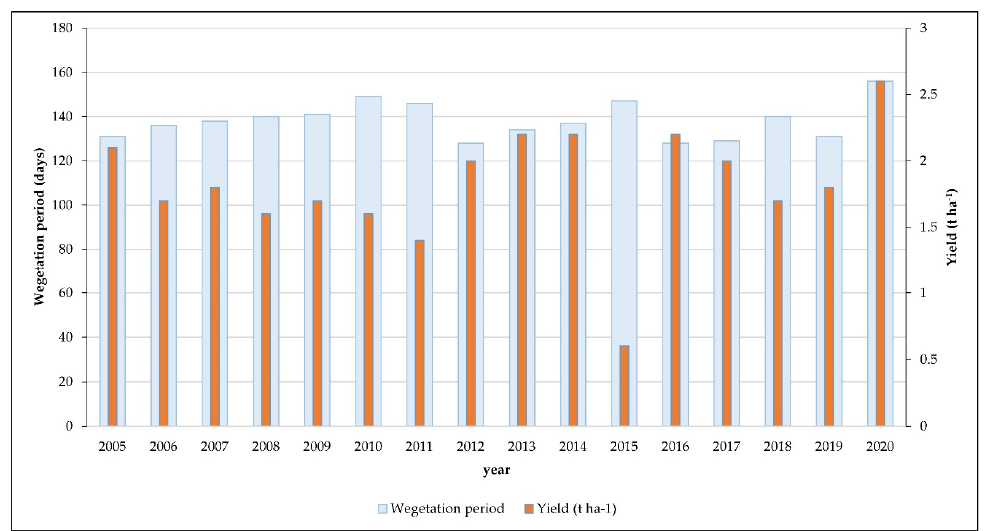
Figure A2. The length of vegetation and the yield of soybean variety Augusta in the period 2005– 2020, ARS D ł o ń , Poland.